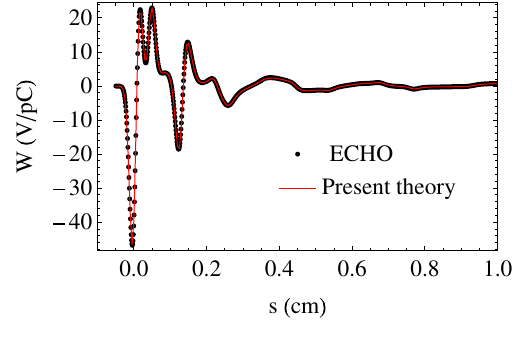
¼ 100 (cid:7) m bunch. z